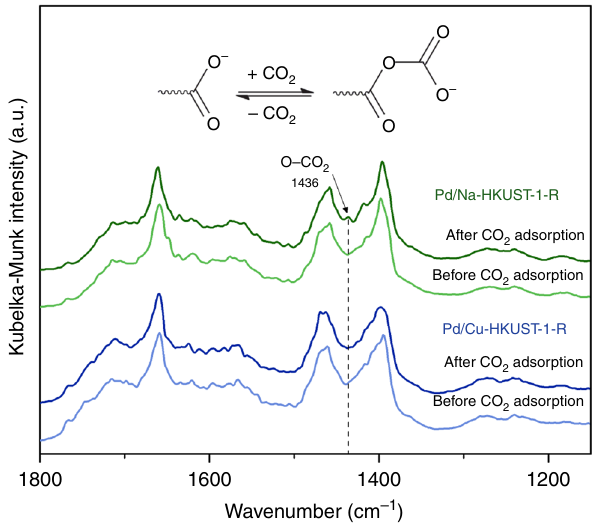
Fig. 3 Comparison of DRIFT spectra of Pd/Na-HKUST-1-R and